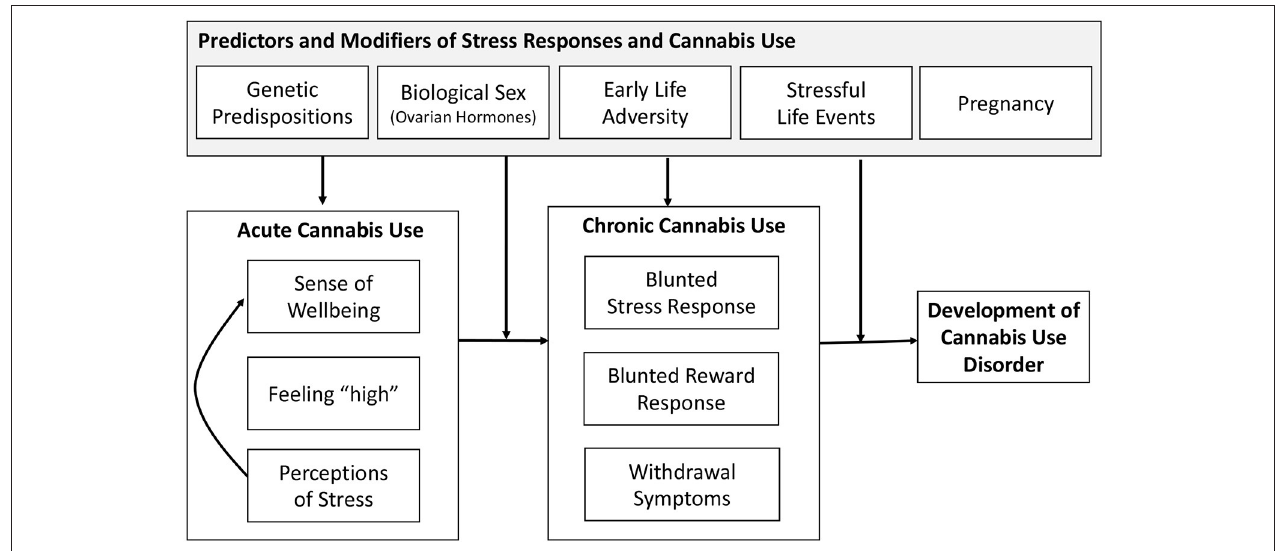
FIGURE 1 | Framework of stress and development of cannabis